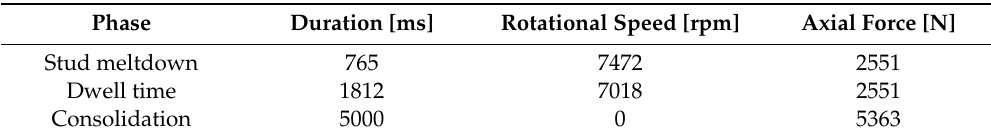
Table 1. Parameters set used for Friction-based Injection Clinching Joining (F-ICJ) joint production. E work = 1415 ± 7 J.